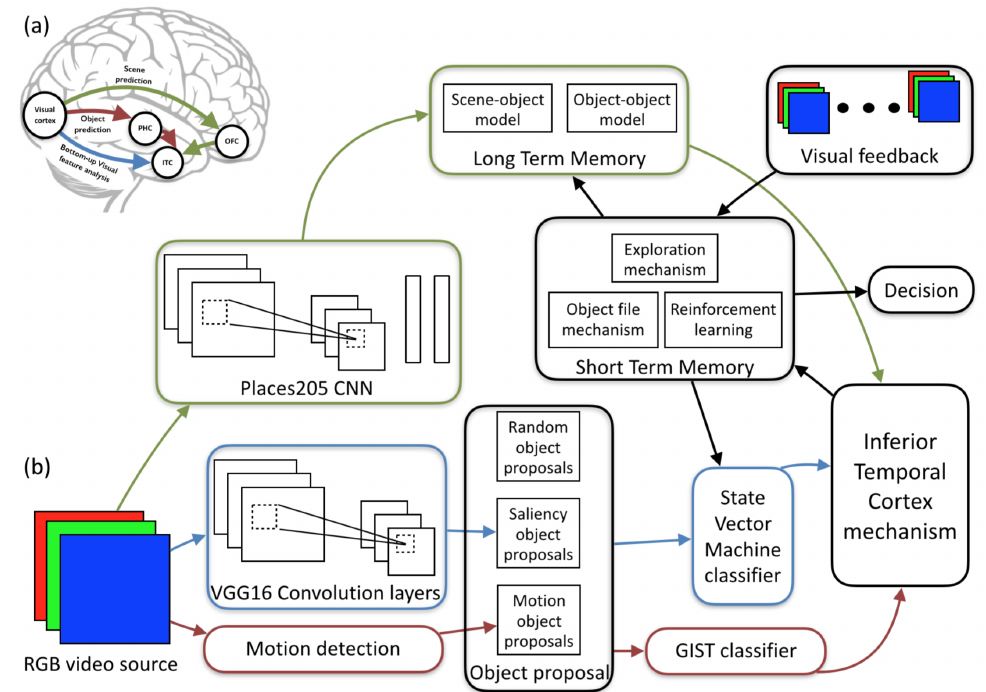
Figure 7. Schematic illustration of ( a ) the main pathways in the human visual system and ( b ) the pathways in the VAP model, using the same color